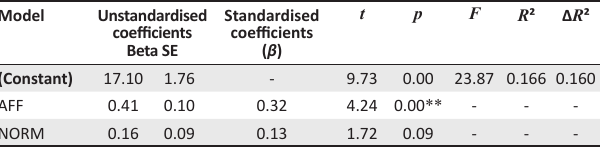
TABLE 3: Multiple regression with vigour (work engagement) being the dependent variable and normative and affective commitments (organisational commitment) the dependent variables .